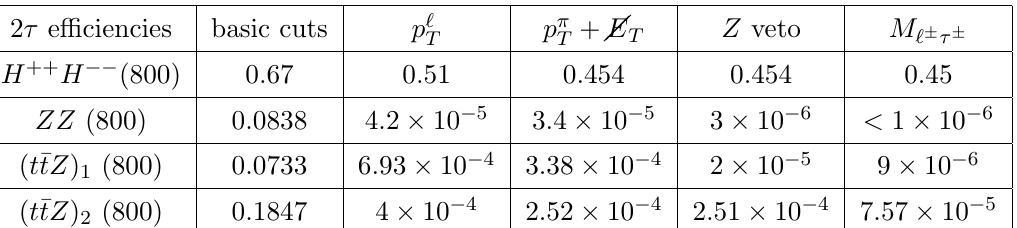
( (cid:0) ) (cid:23) (cid:28) channel at the 14 TeV LHC. We assume M